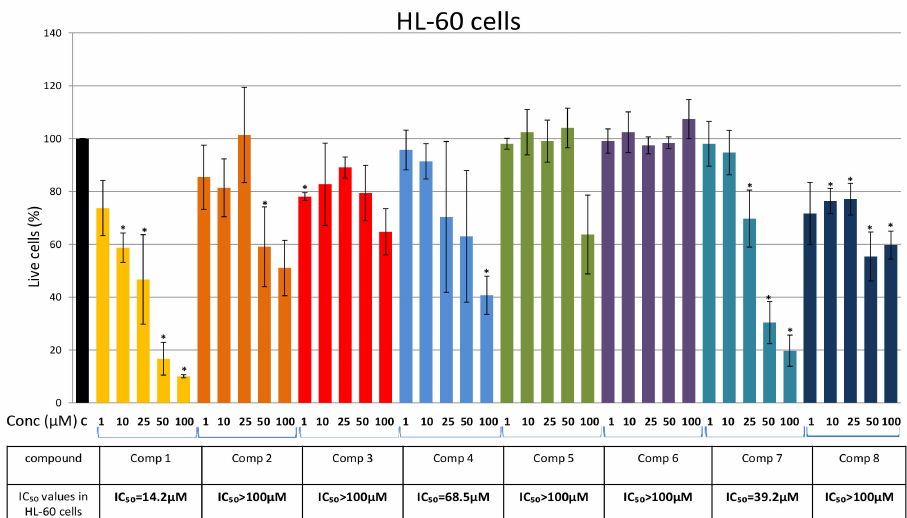
Figure 3. Effects of Compounds 1–8 on HL-60 cells. Cells were treated for 48 h with increasing concentrations (1 µ M, 10 µ M, 25 µ M, 50 µ M, and 100 µ M) of the tested compounds and cell viability was assessed using an MTS assay and expressed as the percentage of absorbance relative to the vehicle control (HL-60 cells treated with DMSO (dimethyl sulfoxide)), which was set at 100%. Data are presented as the mean ± SEM of at least three independent experiments. An asterisk denotes a significant difference from the control (* p < 0.05). SEM—standard error of the mean. U-937 cells showed slightly higher sensitivity to the selected compounds (Figure 4). Compound 7 had the greatest effect on U-937 cells with an IC 50 of 13.2 µ M, whereas Compounds 4, 1, and 5 showed a moderate to weak effect, with IC 50 values of 46.8 µ